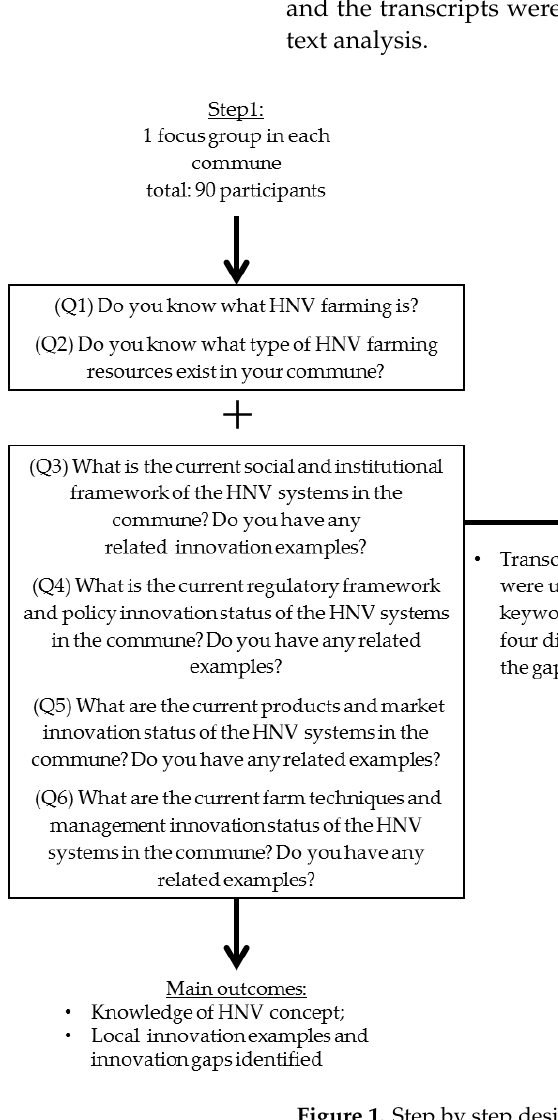
Figure 1. Step by step design and use of focus groups meetings.